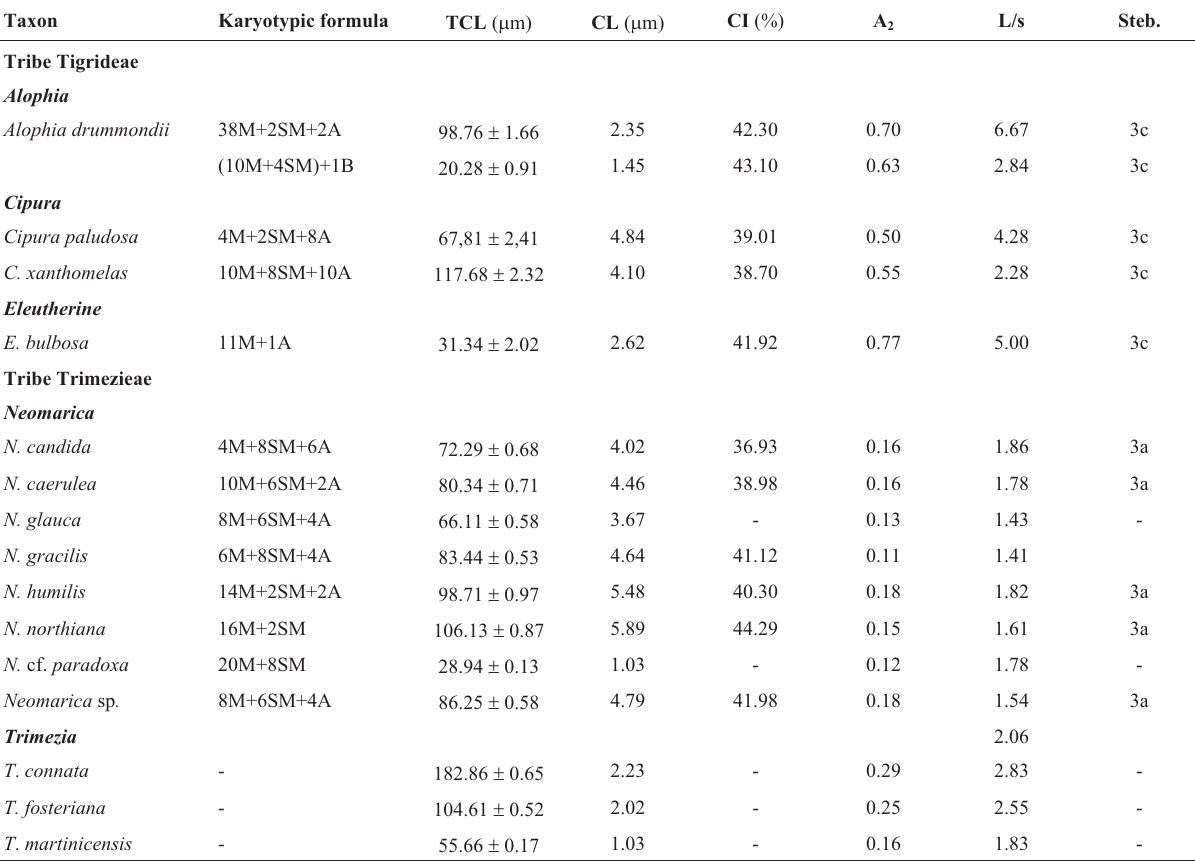
Table 2 - List of analyzed species and their karyotypic formula, total chromosome length (TCL), mean chromosome length (CL), mean centromere index (CI), interchromosomal asymmetry index (A2), proportion between the largest and smallest chromosomes (L/s), Stebbins asymmetry category (Steb.). Taxon Karyotypic